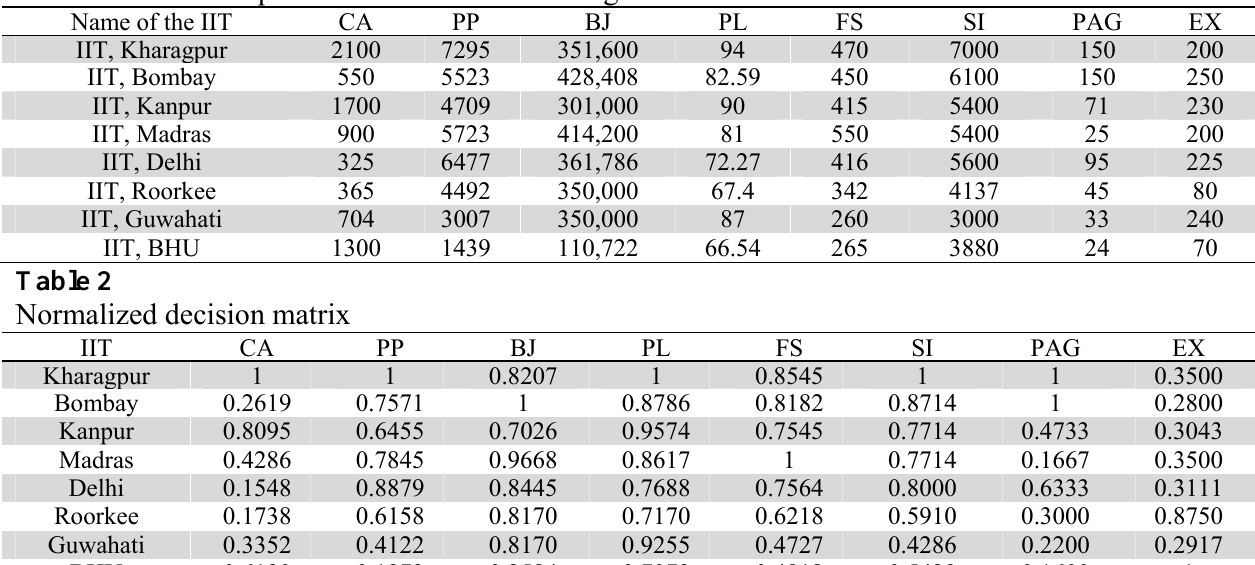
Decision matrix for performance evaluation of eight IITs Name of the IIT